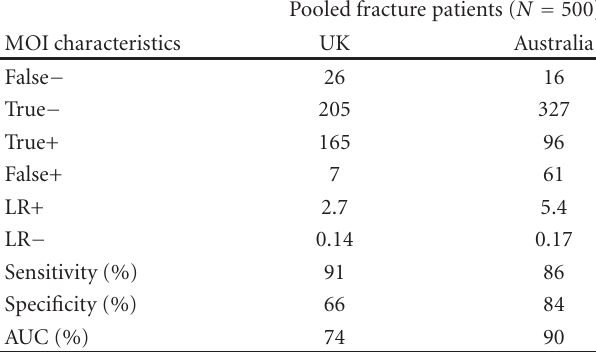
Table 5: Characteristics of diagnostic concordance between MOI and FRAX-BMD to identify Intervention Thresholds presented for UK and Australia (see Table